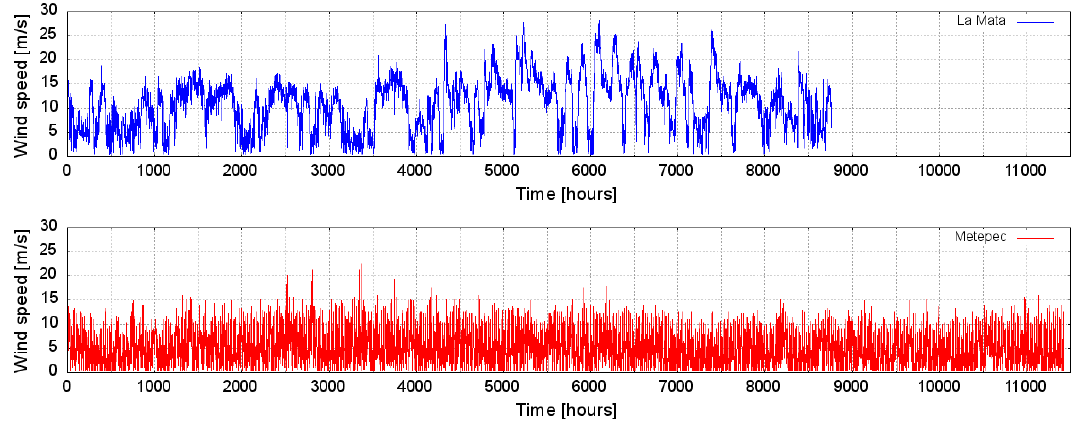
Figure 1. Wind speed time series from La Mata, Oaxaca (hourly averages), and Metepec, Hidalgo (ten-minute averages).